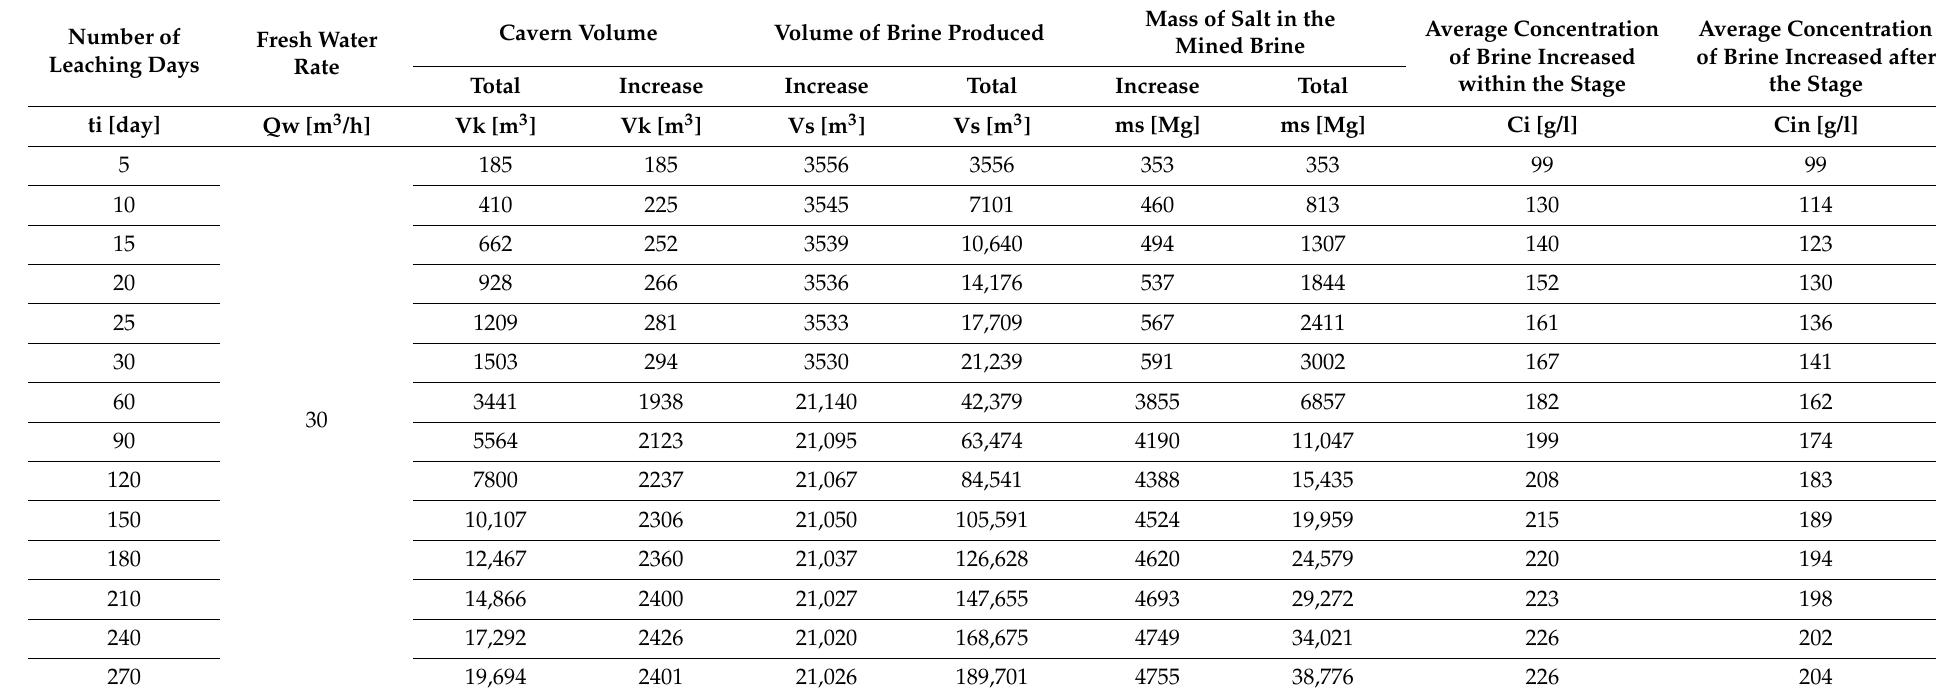
Table 6. Development of the sump leaching process after cutting 1 niche (R1 = 5 m)—Stage I/Scenario 2 (S I/S